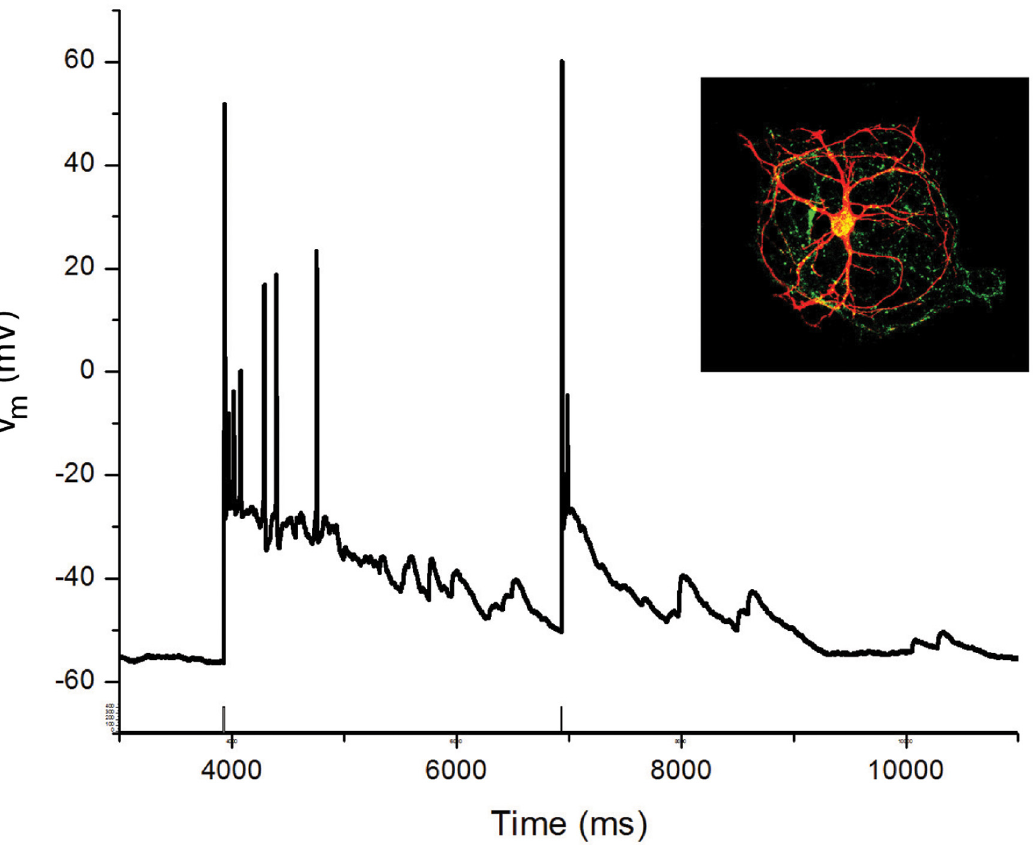
Fig 1. Bursting reverberation in small neuronal islands. A illustration of a network island where neurons are recorded, and filled with biocytin for immunohistochemical identification (red). The island was co-stained with synaptophysin (green dots). B Whole cell recording from a neuron in the island, illustrating responses to two short current pulses that evoke action potentials in the recorded neuron. The first current stimulation evoked an initial spike followed by a depolarization and several additional spikes. The second current pulse, applied 2.5 seconds later produced only a single spike, that was followed by a smaller reverberating network burst, as seen in response to the first stimulus. Scale bar: 20 mV, 1 s.